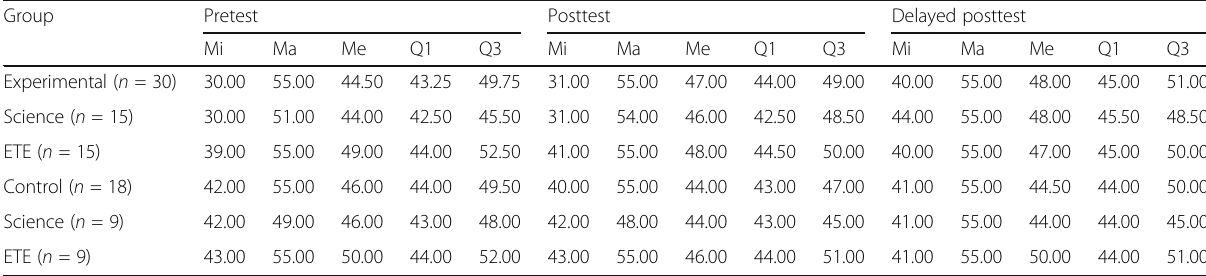
Table 5 Descriptive ordinal statistics by test and group Group Pretest Posttest Delayed